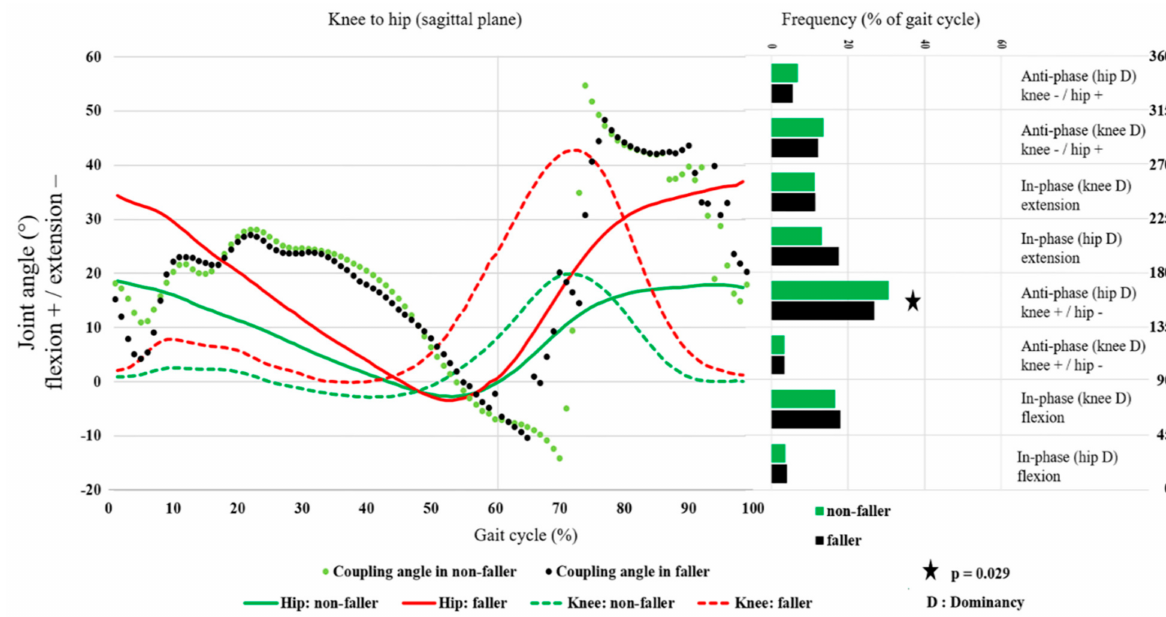
Figure 2. Knee-to-hip angular displacement diagram (left axis) and frequency of coordination patterns (left axis) in the sagittal plane in fallers and non-fallers. The red and green solid lines are angular displacement of knee joint in fallers and non-fallers, respectively. The red and green dashed lines are angular displacement of ankle joint in fallers and non-fallers, respectively. The black and green dots are the frequency scatter of coupling angle in fallers and non-fallers, respectively. The black and green bar charts are the frequency percentage of coupling angle in gait cycle in fallers and non-fallers,